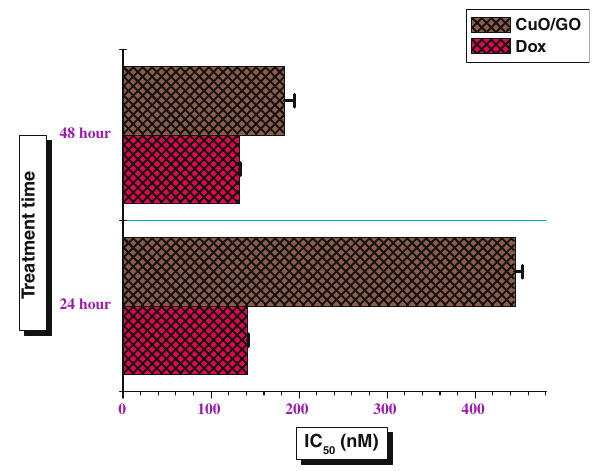
Fig. 9 Cell viability assay of A-431 after treatment with CuO/GO nanocomposite and doxorubicin (control) in IC 50 calculations. Error bar represents the standard deviation of the mean * p ≤ 0.05. Signi fi cant difference ( p ≤ 0.05) within a parameter between two lines is denoted by an